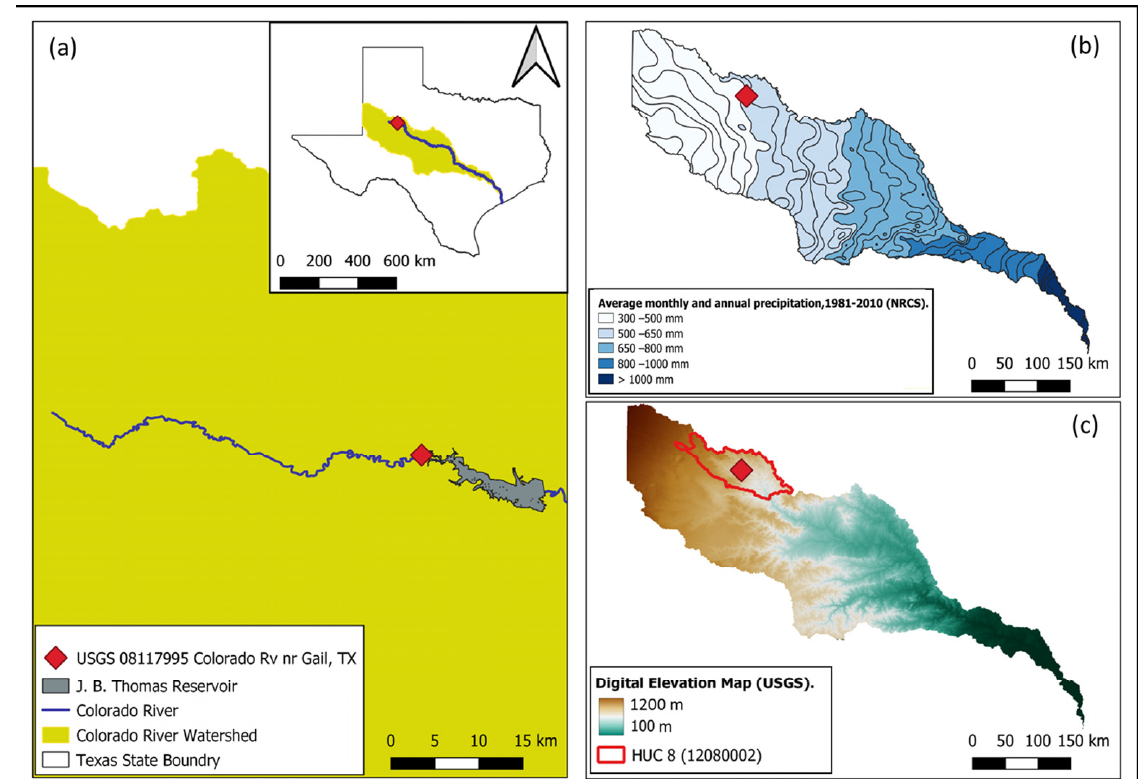
Figure 1. ( a ) Map of the study area and the relative location of the streamflow monitoring station, ( b ) Average precipitation, and ( c ) Digital elevation map of the Colorado River watershed in Texas.